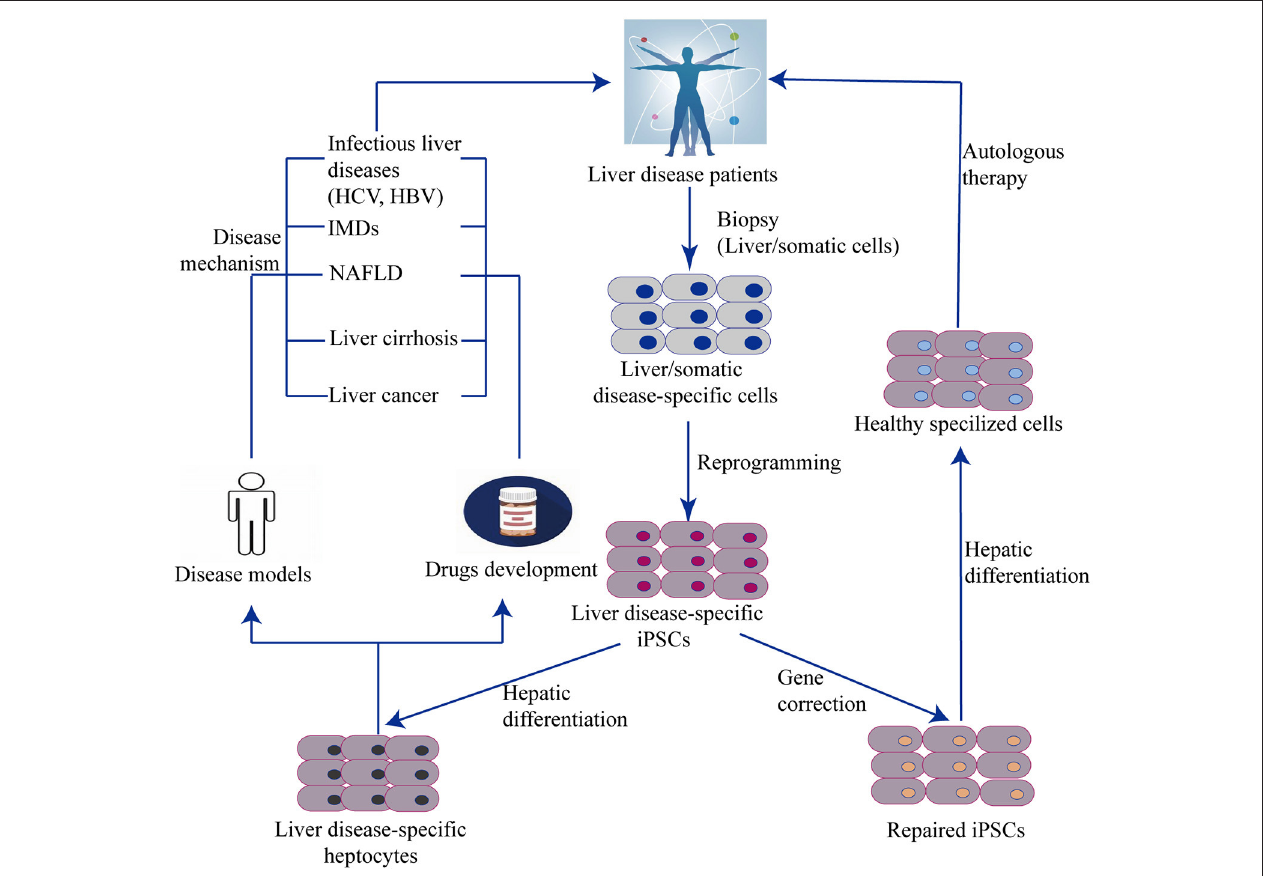
FIGURE 4 | Generation of liver cells from iPSC and their applications. The scheme illustrates an overview of iPSC and organoid technology in relation to liver diseases. Disease specific iPSCs are generated by reprogramming technology from a biopsy of patients. One hand, iPSCs with disease–related gene mutation can be corrected by genome editing and then differentiated into functional disease-specific liver cells in vitro . These corrected cells are used to autologous cell therapy. Another hand, Non-corrected iPSC-derived disease-specific liver cells can be remodeled liver disease phenotypes, pathogenesis, and drug testing. IMD, Inherit metabolism disease; NAFLD, Non-alcoholic fatty liver